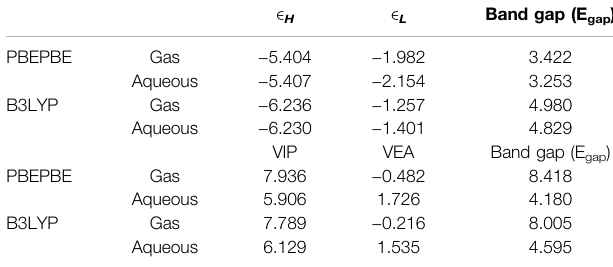
TABLE 5 | Thermodynamics parameters of SMT adsorption by 3D GF-CS. TABLE 6 | ∈ H , ∈ L, and band gaps of the SMZ drug calculated by B3LYP and PBEPBE methods 770 with the 6-31+G (d,p) basis set. The calculation takes placeinthegasphaseandinanaqueoussolutionusingthePCMsolvation